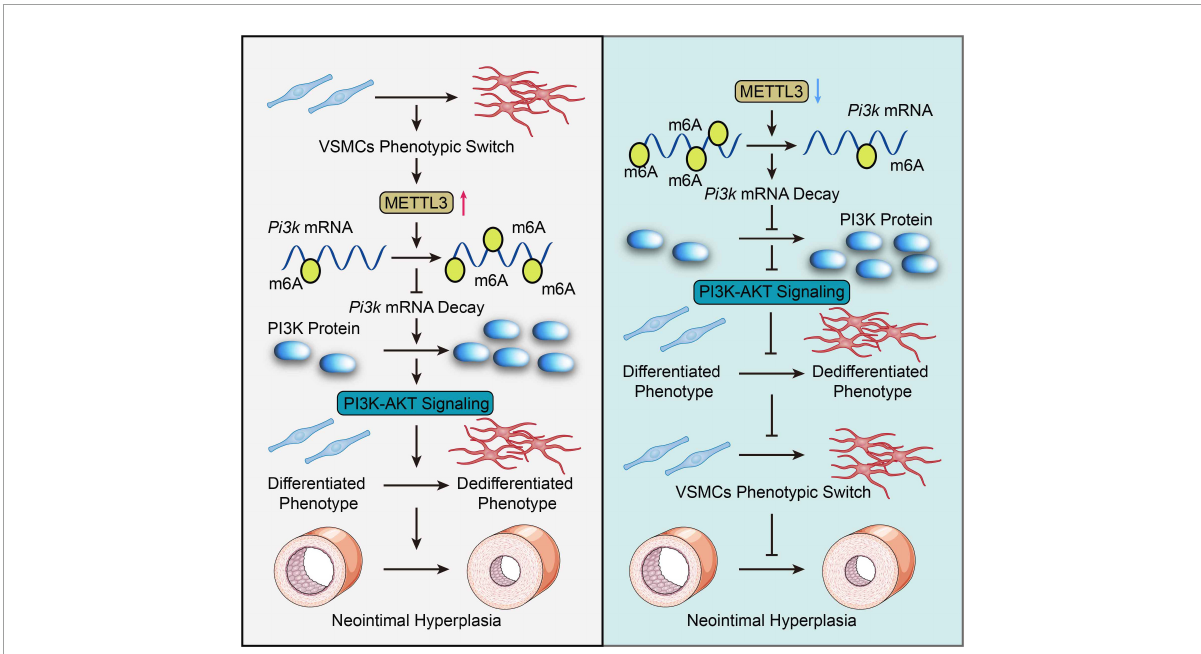
FIGURE6 Graphic summary. In response to vascular smooth muscle cell (VSMC) phenotypic change, methyltransferase like 3 (METTL3) is dramatically up-regulated and catalyzes a global increase in m6A. METTL3 increased the m6A modification of Pi3k mRNA, which hindered its degradation and activated the PI3K-AKT pathway, thereby promoting VSMCs phenotypic switch and neointimal hyperplasia. Inversely, Mettl3 knockdown reversed this facilitated phenotypic switch in VSMCs, as demonstrated by downregulated m6A-dependent decay of Pi3k mRNA thus inactivating the PI3K/AKT signal to inhibit VSMCs phenotype switching and neointimal hyperplasia. Overall, this study highlights the importance of METTL3-mediated m6A in VSMCs phenotype switching and offers a novel perspective on targeting METTL3 as a therapeutic option for VSMCs phenotype switching modulated pathogenesis, including atherosclerosis and